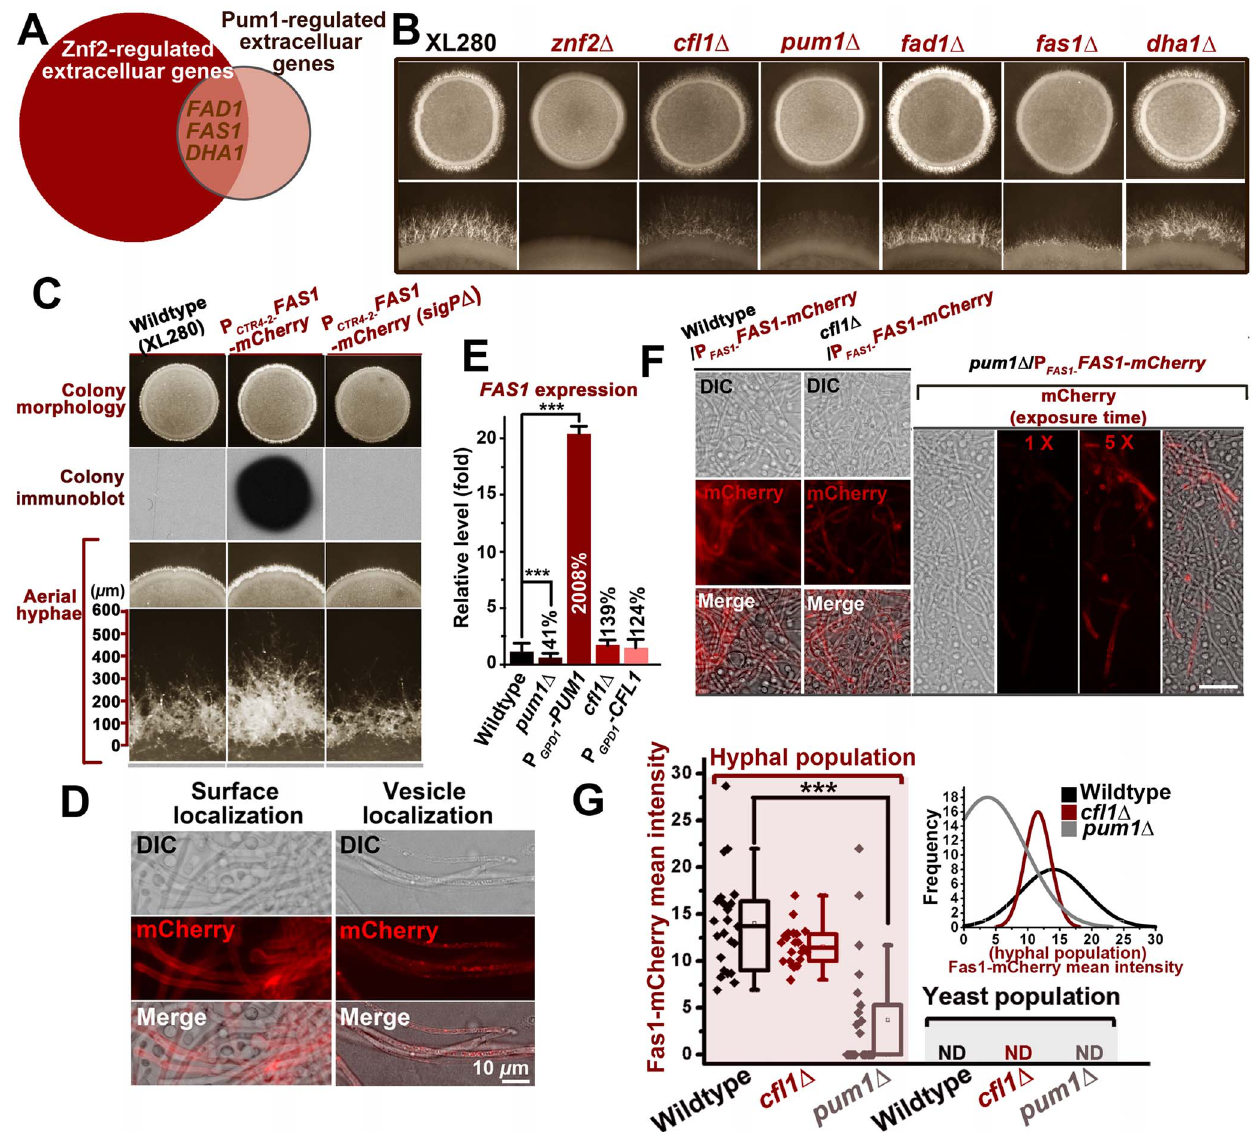
Figure 5. Pum1 directs hyphal initiation and extension partially through a novel hypha-specific extracellular protein Fas1. (A) FAS1 , FAD1 , and DHA1 are the genes encoding extracellular proteins overlapped in the regulons of Znf2 and Pum1. (B) Fas1 recapitulates the role of Pum1 in unisexual hyphal production. The fas1 D mutant, like the pum1 D mutant, showed reduced abundance of aerial hyphae. (C) The indicated strains were grown on V8 agar plate containing 200 m M BCS in the dark at 22 u C. Images of the colonies were photographed after 5 days of incubation. Released Fas1 proteins were detected by colony immune-blot. Only overexpression of Fas1 with intact signal peptide led to a more robust filamentation and longer hyphae. Thus, the secretion of Fas1 is crucial for its biological function. (D) Fas1-mCherry is observed on hyphal surface and in vesicles at 72 hrs post unisexual mating stimulation. (E) The FAS1 expression level was positively regulated by Pum1 based on the transcriptional analysis of its transcript level in the pum1 D mutant and the P GPD1 - PUM1 strain by qPCR. The deletion or the overexpression of CFL1 did not significantly affect the FAS1 expression level. (F and G) Pum1 increased the intensity of Fas1 expression and reduces its stochasticity. The average intensity of Fas1-mCherry fluorescence was dramatically reduced in the absence of Pum1, but not Cfl1. The deletion of PUM1 led to a much higher variability in the Fas1-mCherry level among hyphal cells during unisexual filamentation (Inset of Figureoˆ 5G). The frequencies of Fas1-mCherry’s mean intensity in the hyphal population were plotted for the wildtype strain, the cfl1 D mutant, and the pum1 D mutant (software: ZEN